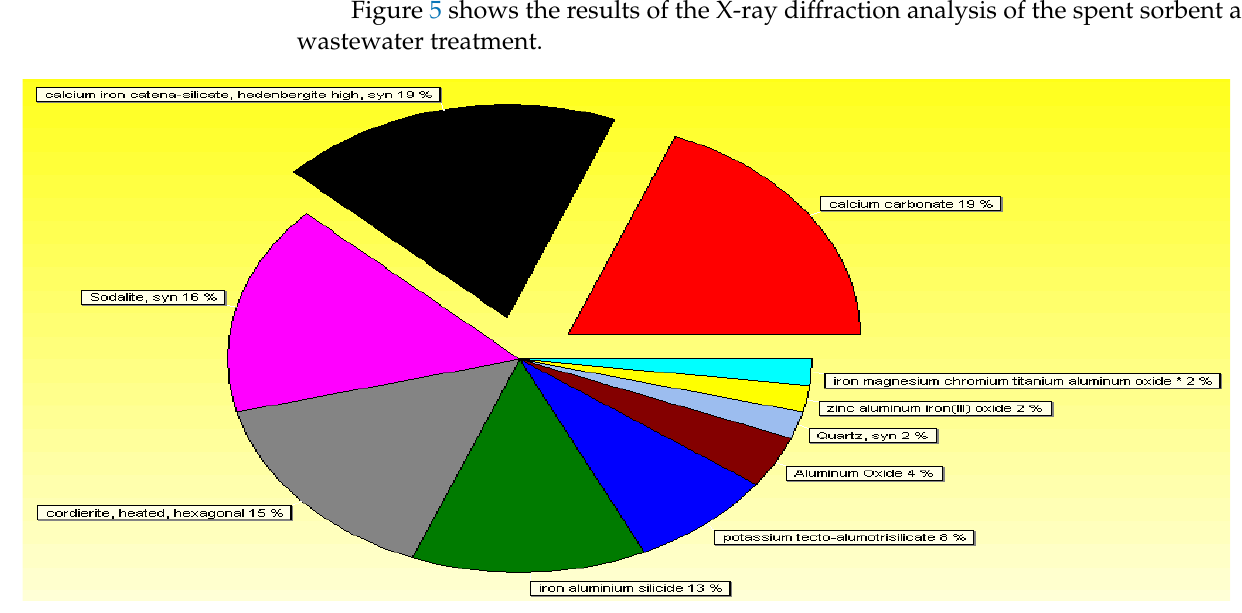
Table 5. Test results for freshly molded samples.